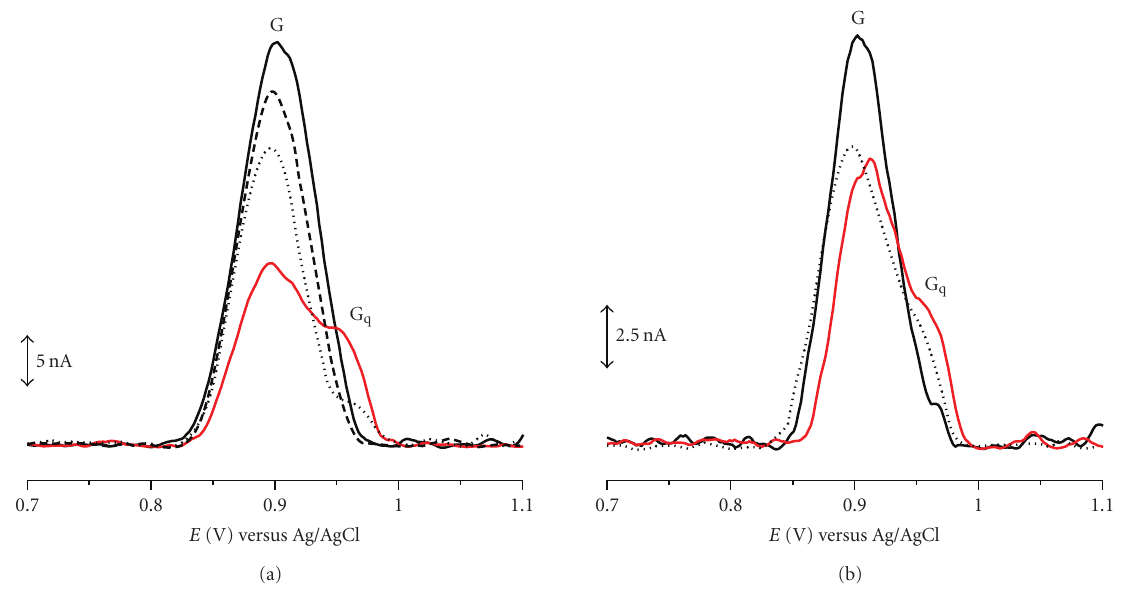
Figure 4: Baseline corrected DPV obtained with the GC electrode in a solution of 1 μ gmL − 1 eTBA in pH 7.0 0.1 M phosphate bu ff er: (a) (solid line) in the absence and in the presence of 100 mM KCl after (dashed line) 0 hour, (dotted line) 1 hour and (red line) 24 hours of incubation and (b) in the presence of (solid line) 50, (dotted line) 100 and (red line) 200 mM KCl after 24 hours of